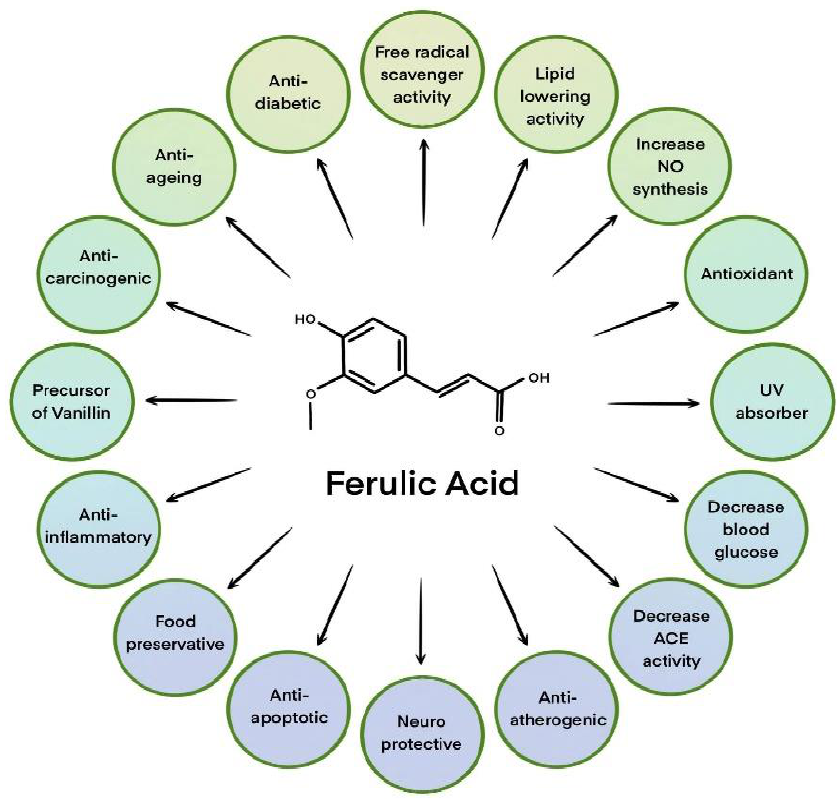
Figure 1. Various applications of ferulic acid in cosmetic products. Based on